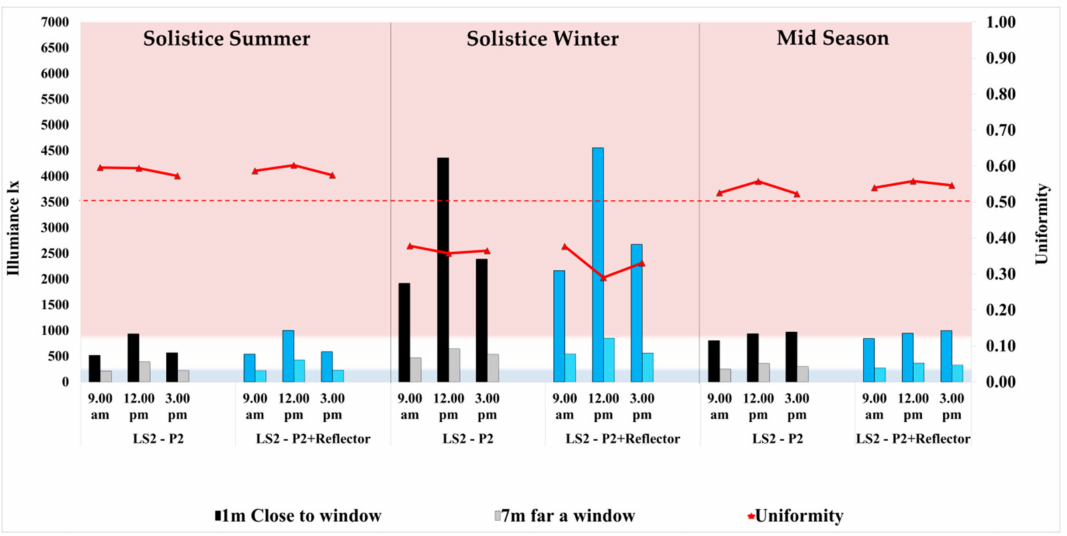
Figure 7. The performance of a reflector on the top of window combined with external and internal light